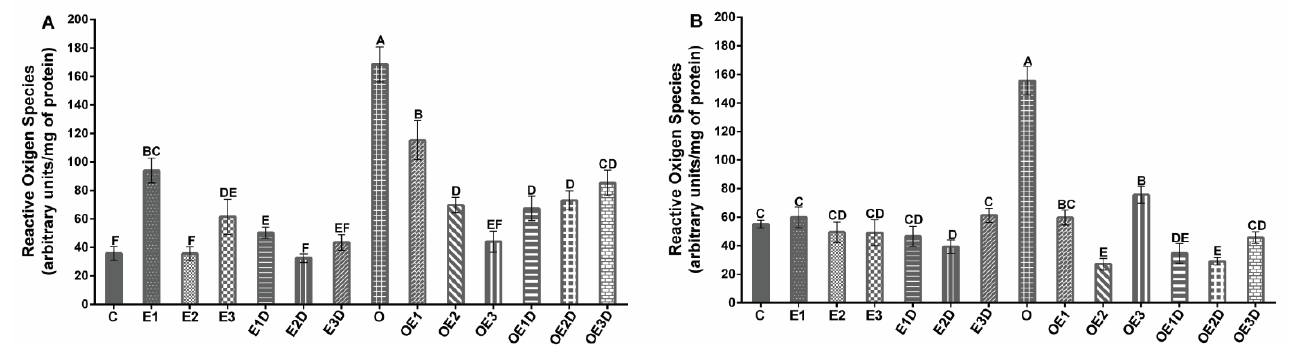
Figure 3. Effect of different exercise intensities and diazoxide on lipid peroxidation of skeletal muscle in obese rats. ( A ) Soleus muscle ( B ) EDL muscle. C: control; D: diazoxide; E1: low-intensity ex- ercise; E2: moderate-intensity exercise; E3: high-intensity exercise; E1D: low-intensity diazoxide ex-